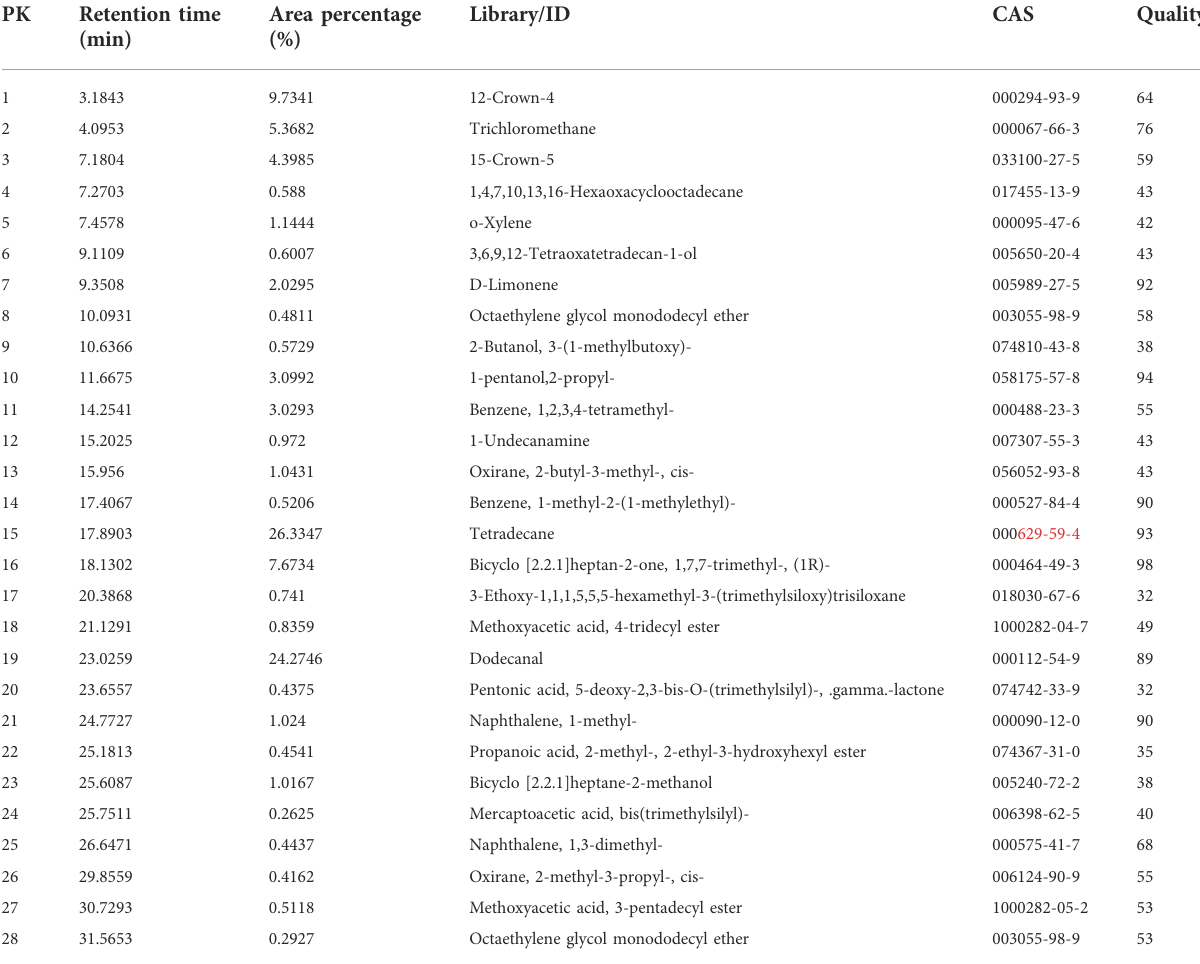
TABLE 1 Volatiles from common beans Phaseolus vulgaris pods, identi fi ed by gas-chromatography coupled with mass